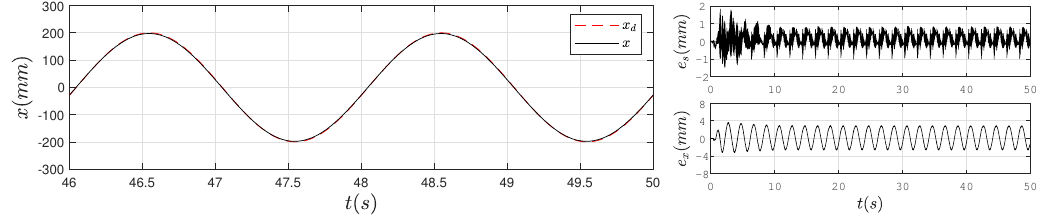
Figure 8. System output under the ARSCR controller and low-frequency excitation.